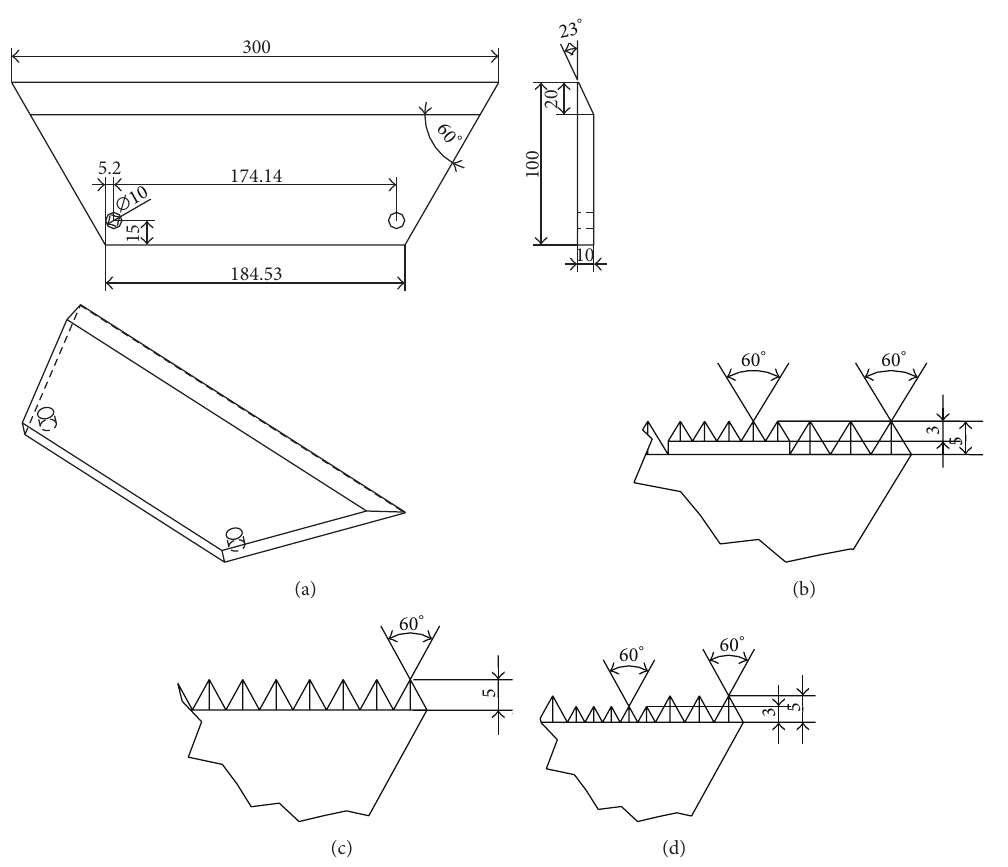
Figure 2: (a) Reference blade A, (b) bionic blade B, (c) bionic blade C, and (d) bionic blade D